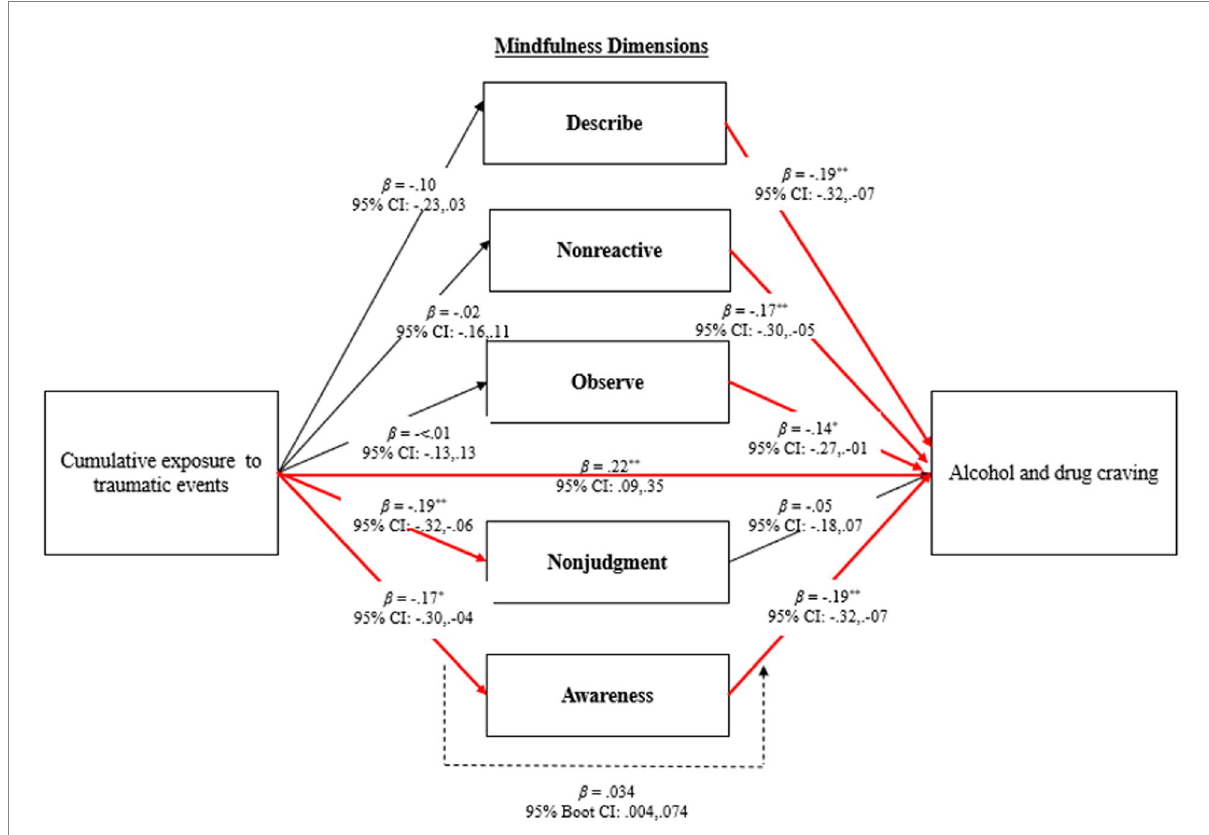
FIGURE 2 Results for direct and indirect associations between cumulative exposure to traumatic events, mindfulness, and craving. * p < 0.05; ** p < 01; Models controlled for